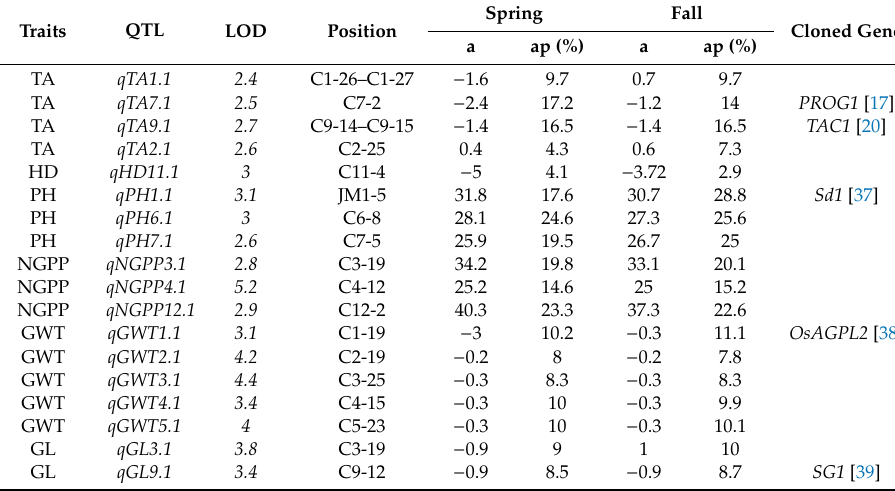
Table 3. List of 36 QTLs identified from